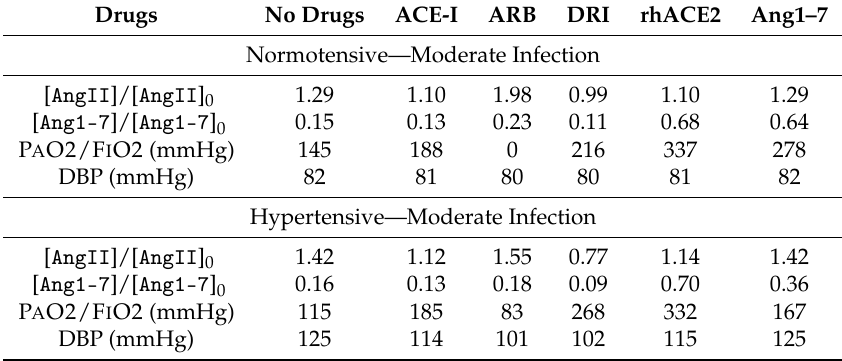
Table 5. Predicted effects on AngII and Ang1-7 levels, P A O2/F I O2, and DBP upon drug administration to normotensive and hypertensive COVID-19 patients. The drug administrations are modeled by γ ACE I , γ ARB , γ DRI , γ rhACE 2 = 0.5, and η Ang 17 = 25 fmol/(mL min) and moderate −